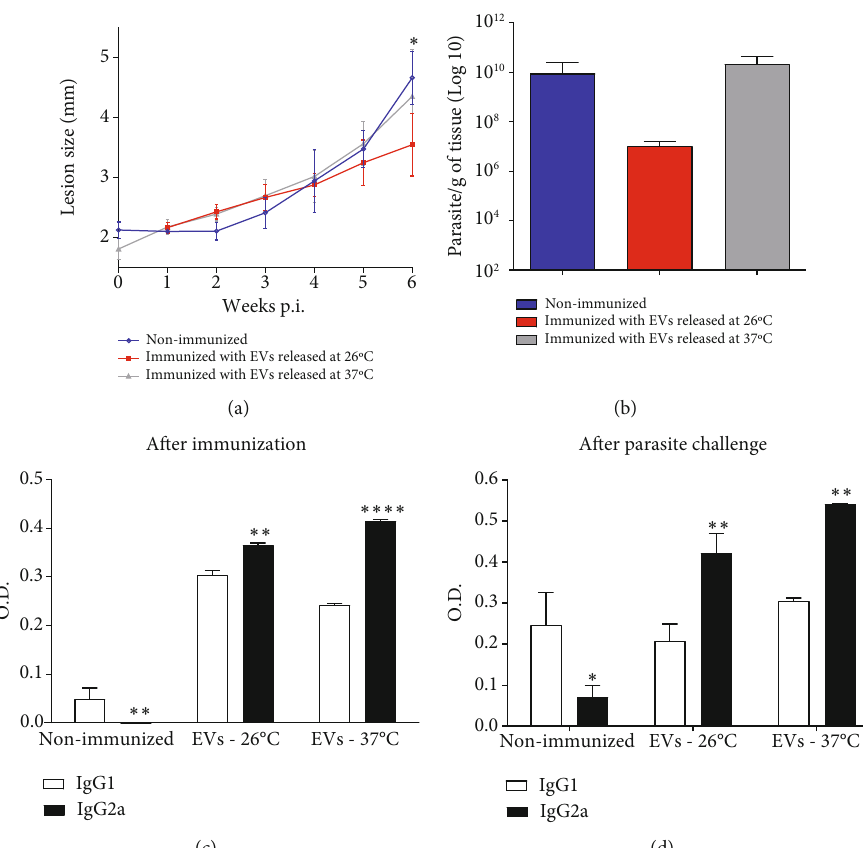
Figure 3: Immunization with EVs released by promastigotes of the reference strain of L. amazonensis incubated at 26 or 37 ° C. BALB/c mice were handled with the 2 doses protocol of EVs from L. amazonensis reference strain. (a) The lesion size (millimeter (mm)) measurements. Each point represents the average of the individual measurement ( n = 5 ). ANOVA followed by a post hoc Tukey ’ s test was performed ∗ P < 0 : 05 . Nonimmunized mice compared with mice immunized with EVs obtained at 26 ° C. (b) Parasite load ( n = 5 ). Bars denote the average of 5 measurements, and error bars denote the SD. ANOVA followed by a post hoc Tukey ’ s test. (c) Production of IgG1 and IgG2a isotype antibody anti-EVs after two doses of EV immunizations. (d) Measurement of the IgG1 and IgG2a isotype antitotal extract of L. amazonensis in mice immunized and infected with the parasite. Bars represent the average of 5 measurements, and error bars show the SD. Two-way ANOVA followed by a post hoc Sidak test ð ∗ P < 0 : 05, ∗∗ P < 0 : 01,and ∗∗∗∗ P < 0 : 001 IgG1versusIgG2a in eachgroup Þ . EVs − 26 ° C — mice immunized twice with EVs obtained from L. amazonensis promastigotes incubated for 4 h at 26 ° C; EVs − 37 ° C — mice immunized with 2 doses of EVs obtained from L. amazonensis promastigotes incubated for 4 h at 37 ° C. Data are representative of 3 independent